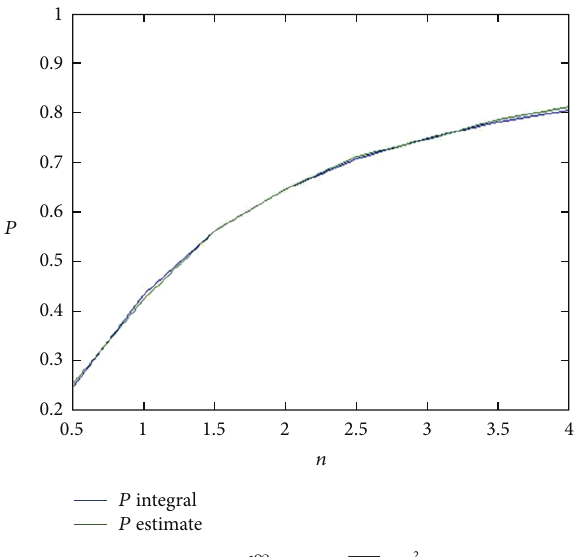
Figure 1: A plot of (2/√𝜋)∫ mate 𝑀(𝛽)/𝑀 for 𝑀 = 2000